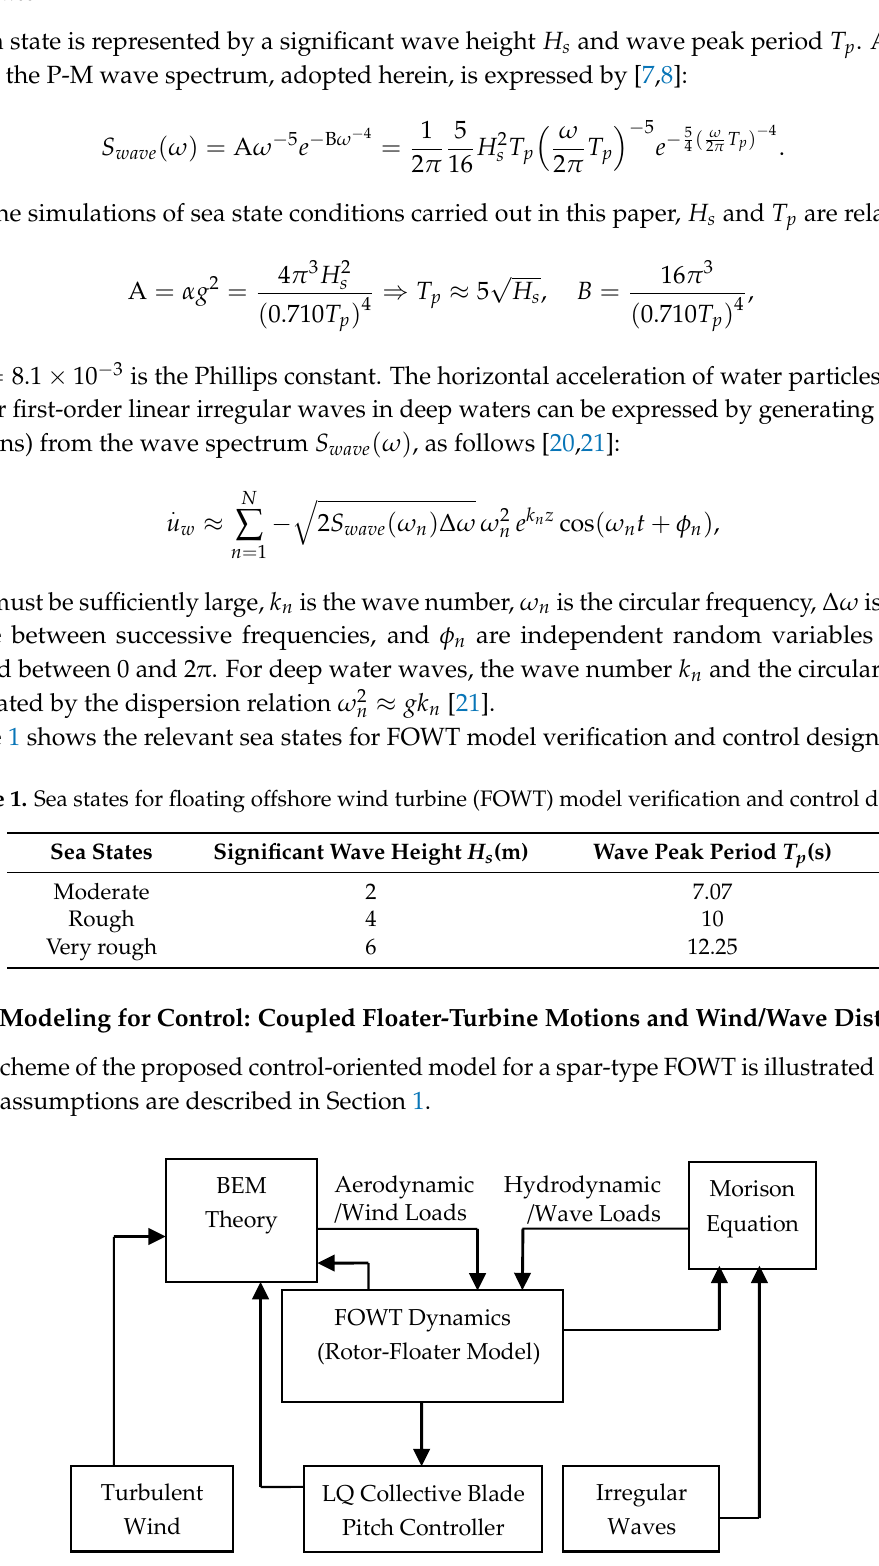
Figure 1. Block diagram of the proposed spar-type FOWT model for control design and simulation.